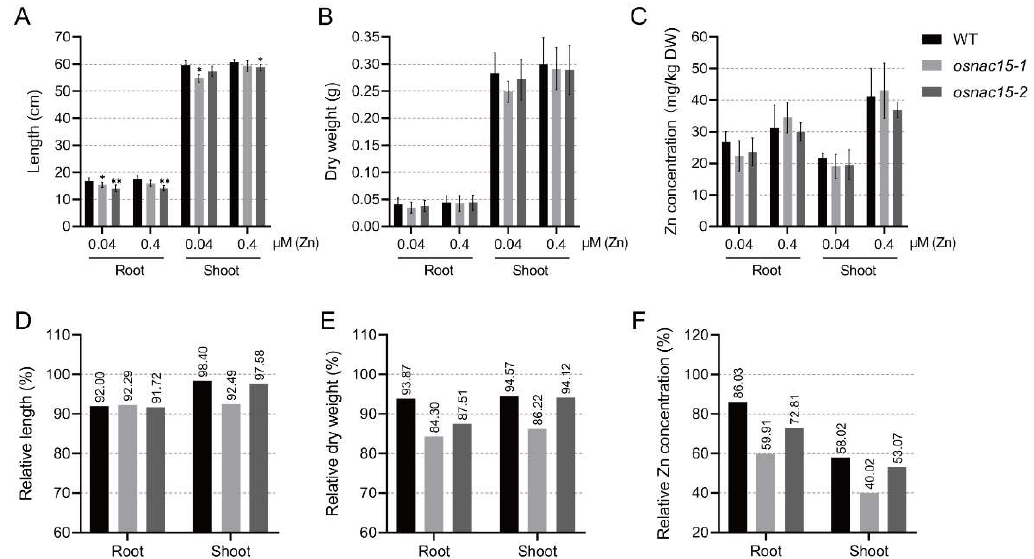
Figure 3. Phenotypic analysis of OsNAC15 knockout lines for ZDT. Length ( A ), dry weight ( B ), Zn concentration ( C ), relative length ( D ), relative dry weight ( E ) and relative Zn concentration ( F ) of roots and shoots in the WT and knockout lines. The plants were grown in a 1/2 KB solution containing 0.04 µM or 0.4 µM ZnSO 4 for 28 days. Data are represented as means ± SD of three biological replicates. * and ** indicate significant differences at p < 0.05 and 0.01, respectively, by Student’s t - test.